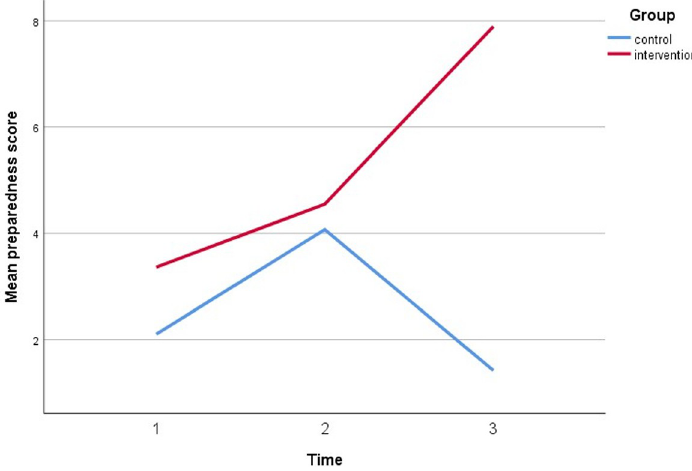
Fig 4. A plot of preparedness scores among respondents, showing an interaction between groups and time.